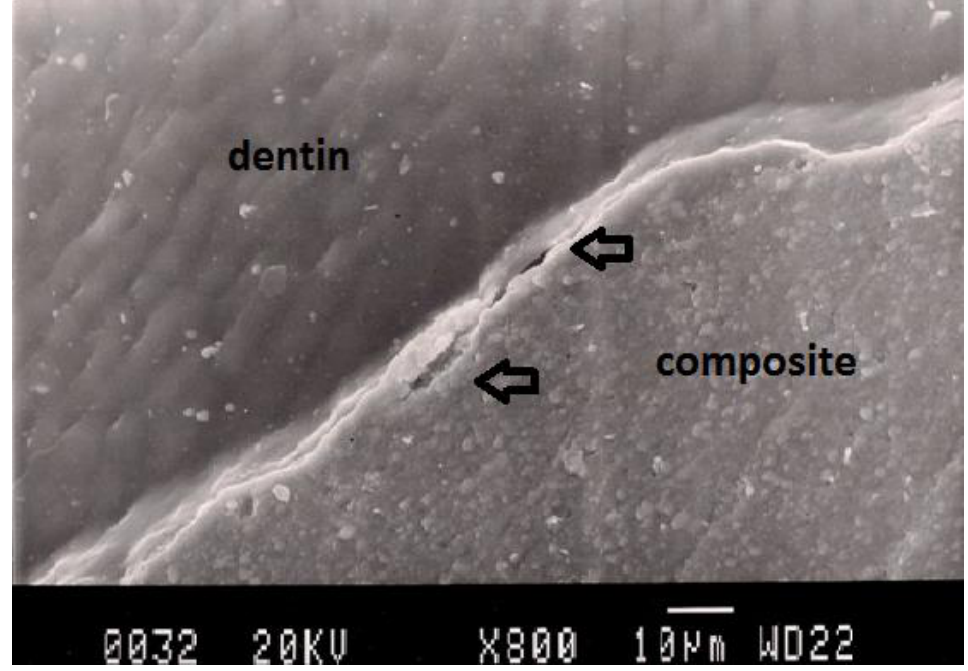
Figure 2. Representative SEM photomicrograph of a Group 1 specimen. The arrows indicate microgap between composite restoration and dentin.